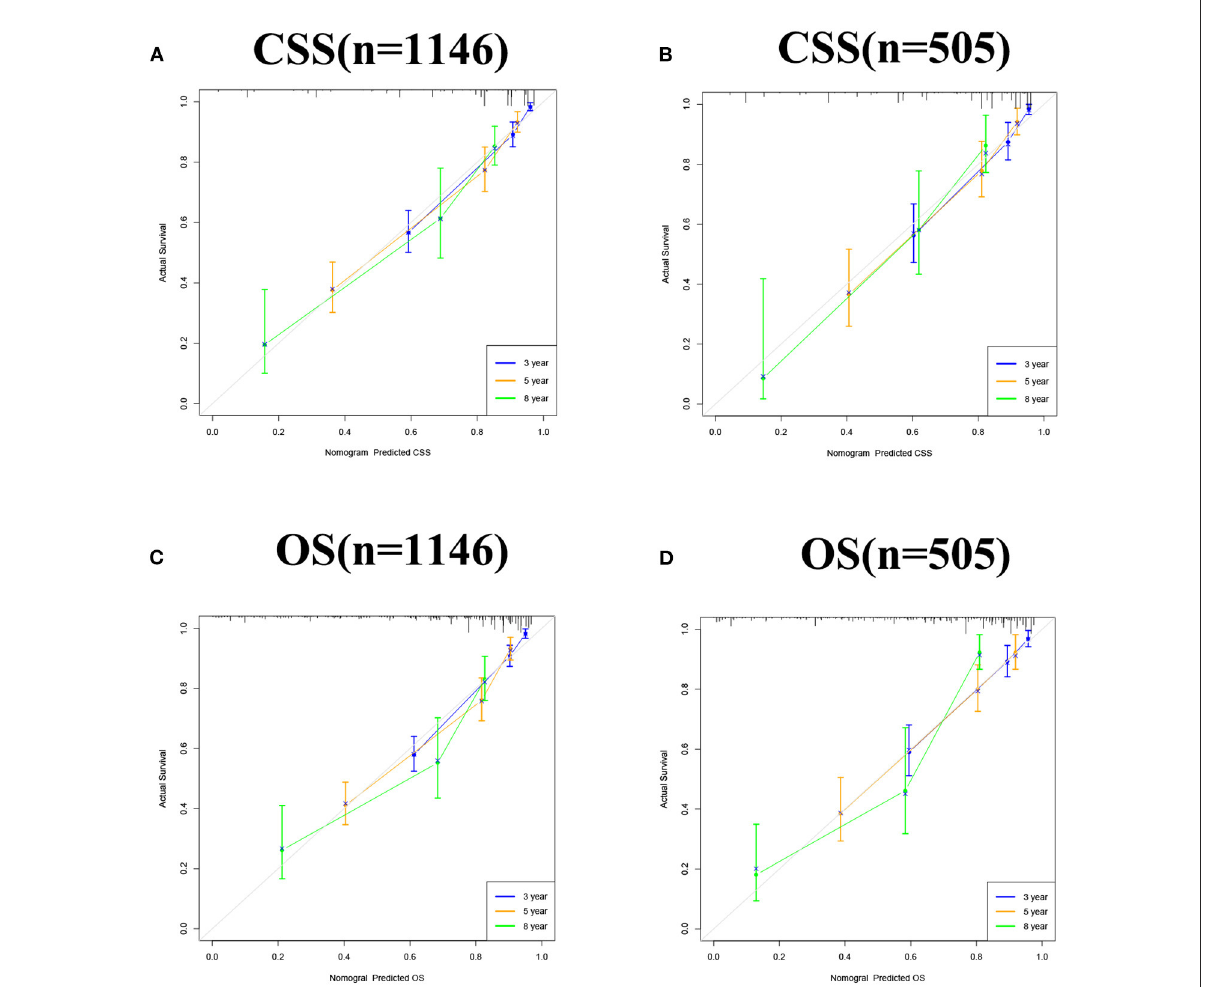
FIGURE3 Calibration curve of the nomograms for predicting 3-, 5-, and 8-year CSS and OS in middle aged high-risk prostate cancer. (A) Calibration curve of the nomograms for predicting 3-, 5-, and 8-year CSS in the training set. (B) Calibration curve of the nomograms for predicting 3-, 5-, and 8-year CSS in the validation set. (C) Calibration curve of the nomograms for predicting 3-, 5-, and 8-year OS in the training set. (D) Calibration curve of the nomograms for predicting 3-, 5-, and 8-year OS in the validation set. The horizontal axis is the predicted value in the nomogram, and the vertical axis is the observed